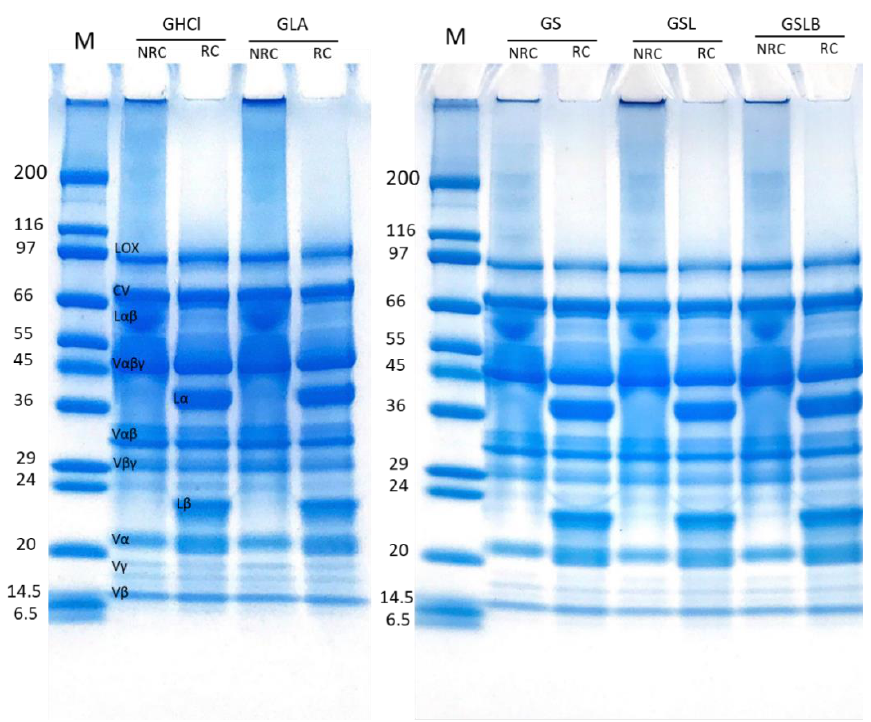
Figure 6. Electrophoretic profiles of globulin fractions obtained by controls (GHCl, GLA) and fermentations (GS, GSL, GSLB) in reducing (RC) and non-reducing (NRC) conditions.